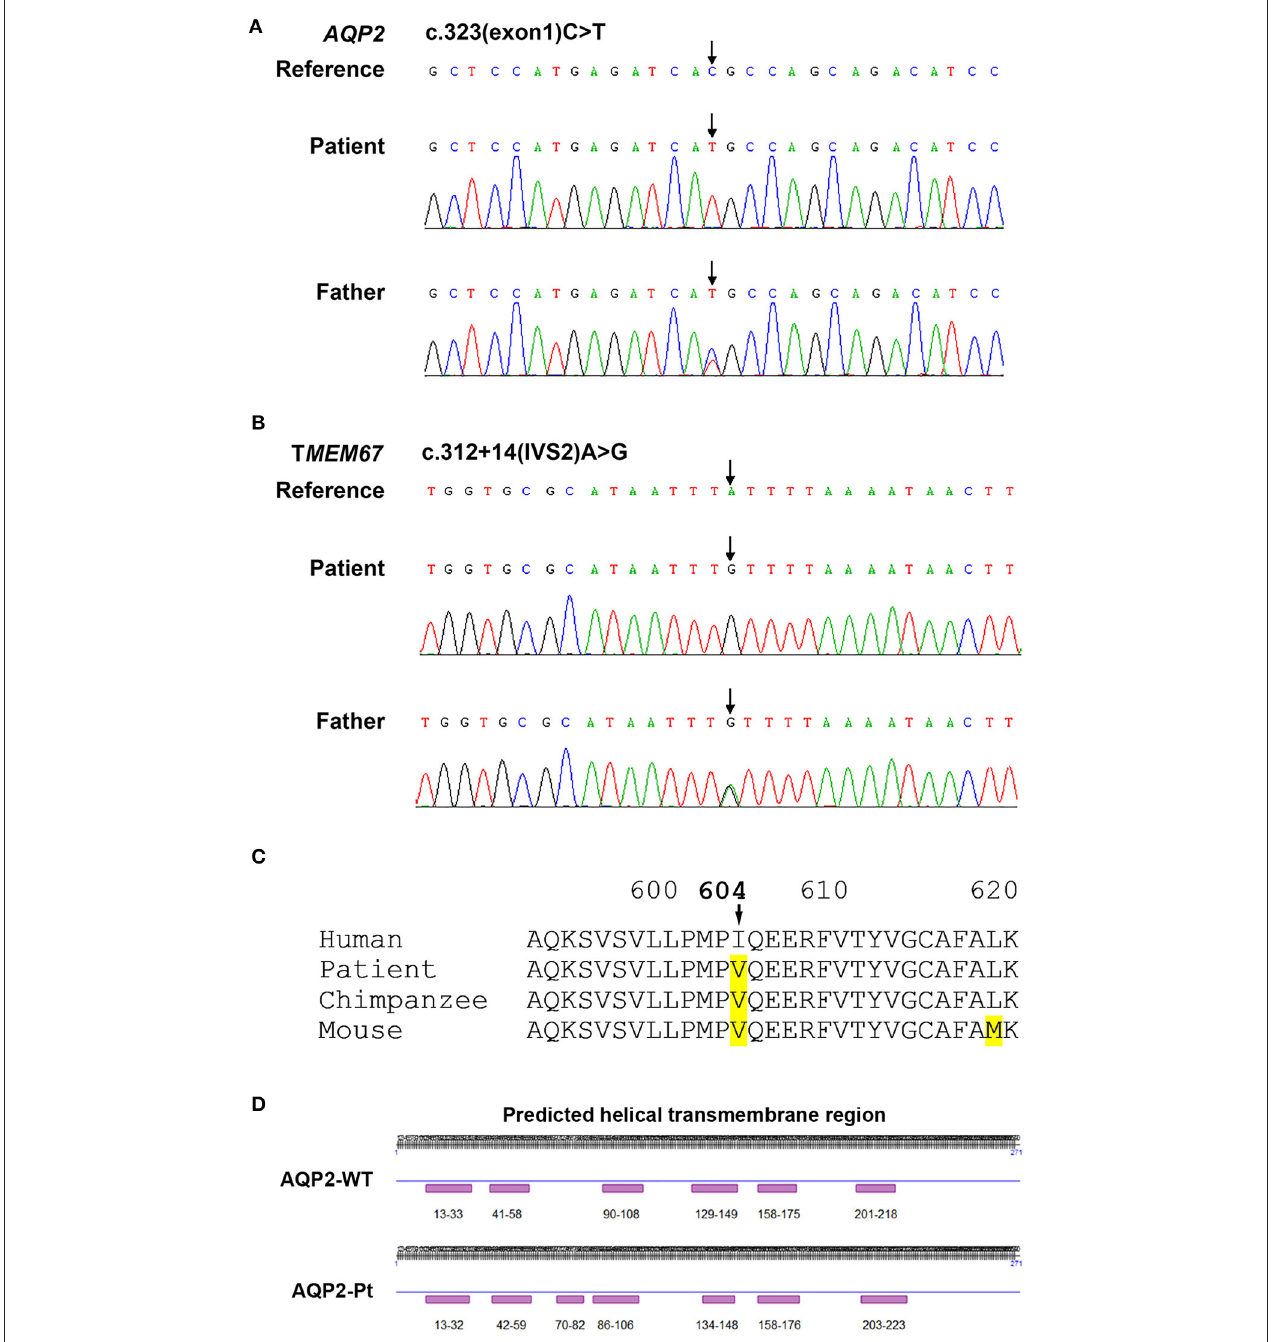
FIGURE 2 | Sequencing analysis for AQP2 and TMEM67 genes. (A) Sequencing analysis shows a homozygous 323C > T transition in the exon 1 of AQP2 gene in the CNDI patient (Arrow, middle ). A heterozygous 323C > T transition occurs at the same position in AQP2 gene of the patient’s father (Arrow, lower ). (B) Sequencing histogram shows a homozygous A > G transversion in the second intron of TMEM67 gene close to the putative splicing site (Arrow, middle ). The father of the patient harbored a heterozygous mutation at the same position (Arrow, lower ). (C) Sequence alignment of amino acids demonstrates the natural variant of the I604V missense mutation in TMEM67 in chimpanzee and mouse, implying polymorphism. (D) Predicted secondary structural changes caused by T108M variation in AQP2.